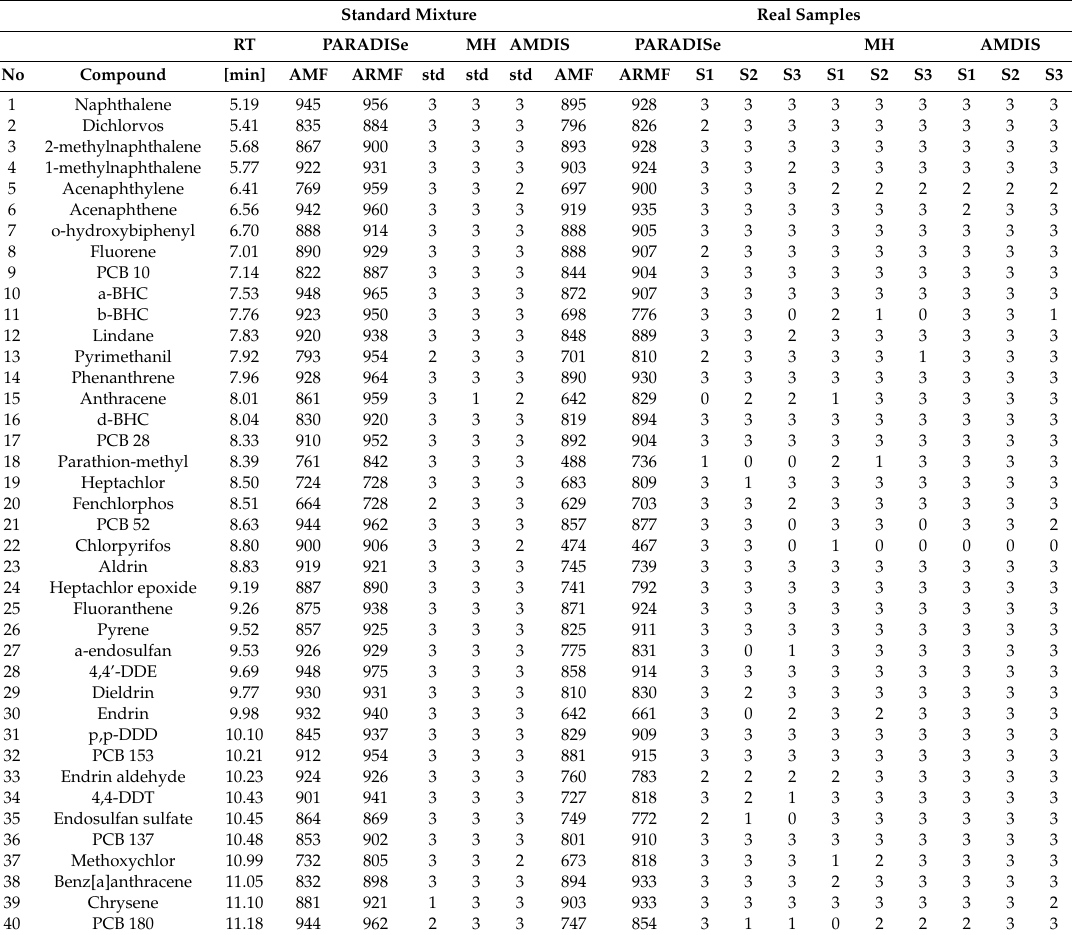
Table 1. Average NIST MS search match factor (AMF), average NIST MS search reversed match factor (ARMF), and the number of replicates for the standard mixture (std), sample S1 (S1), sample S2 (S2), and sample S3 (S3) for PARADISe computer program, MassHunter (MH), and AMDIS